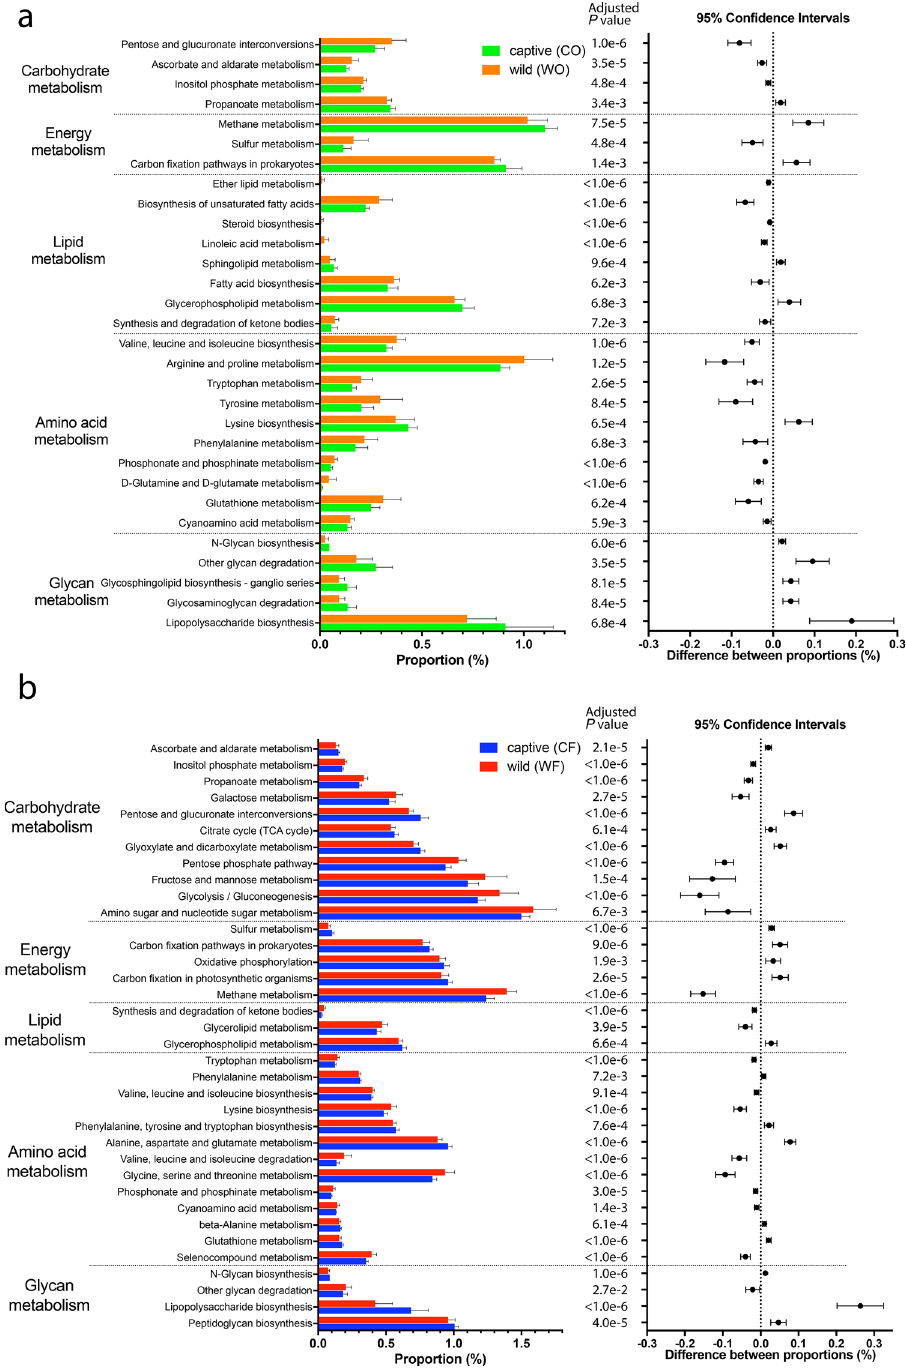
Figure 4. Functional pathway inference of oral and fecal microbiota in wild and captive long-tailed macaques. The significant differential KEGG ortholog (KO) pathways in ( a ) oral microbiome and ( b ) Fecal microbiome of wild and captive macaques analyzed by PICRUSt2 (statistically tested by multiple t -test with 1% false discovery rate (FDR) correction). The graph on the left shows the pathway abundances while the right shows 95% confidence intervals of differential